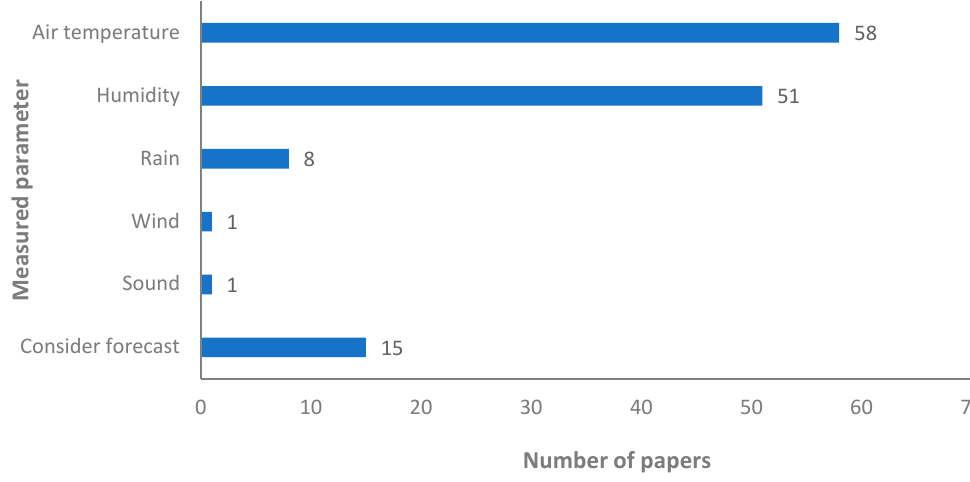
Figure 8. Monitored atmospheric parameters in papers that propose an irrigation system.